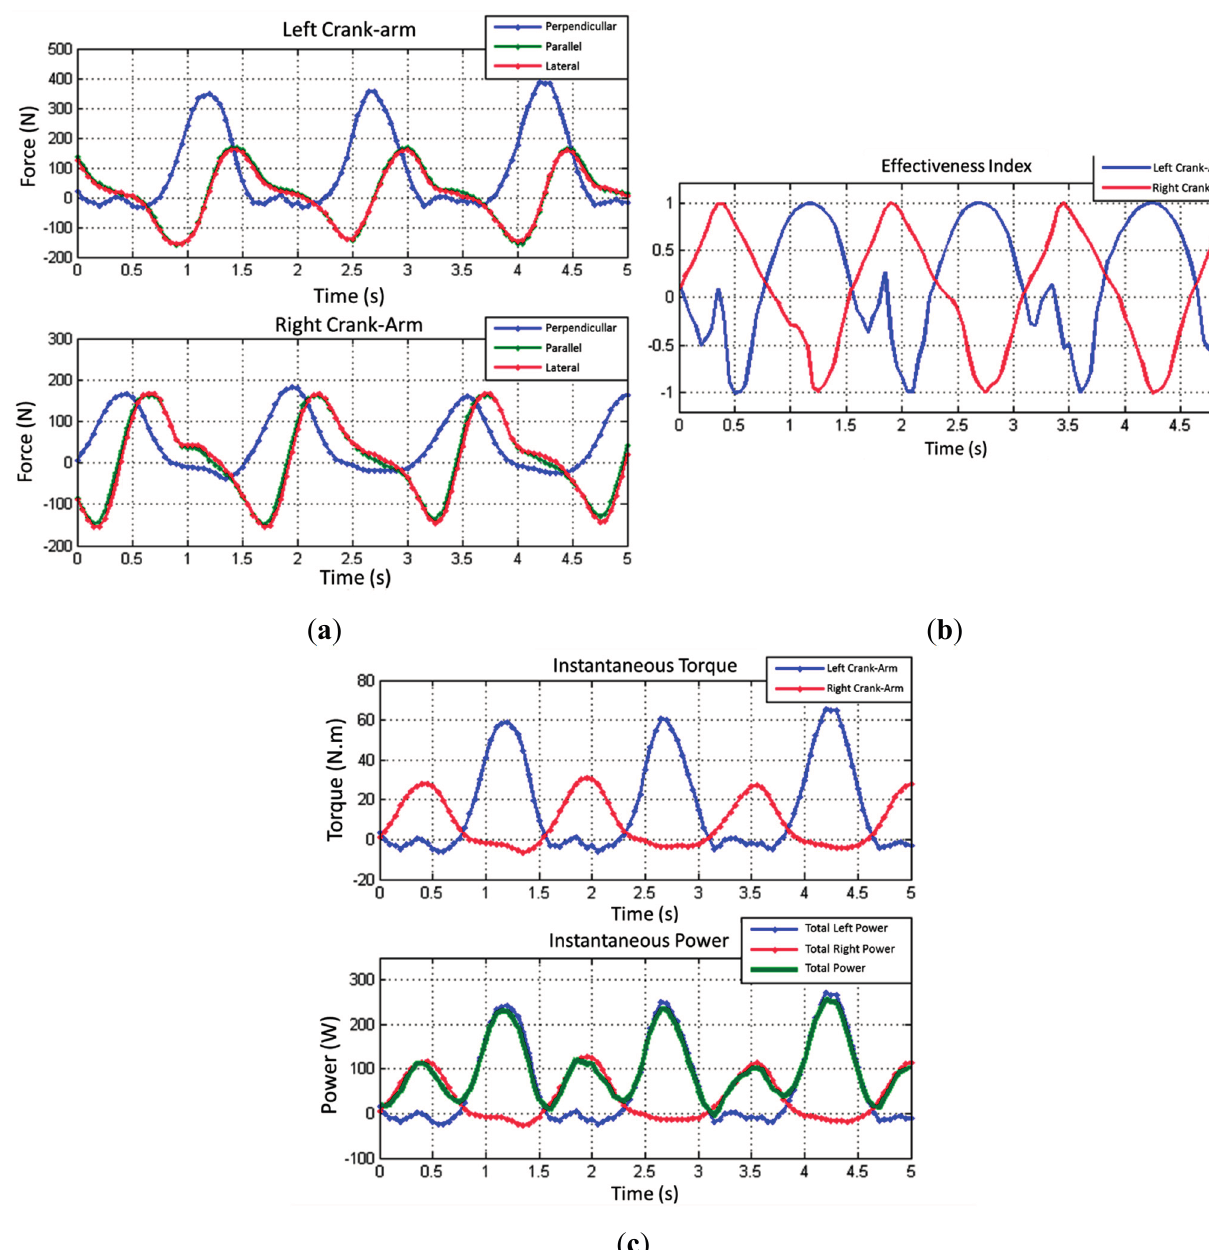
Figure 15. Outdoor test: ( a ) Forces; ( b ) Effectiveness Index; ( c ) Torque and